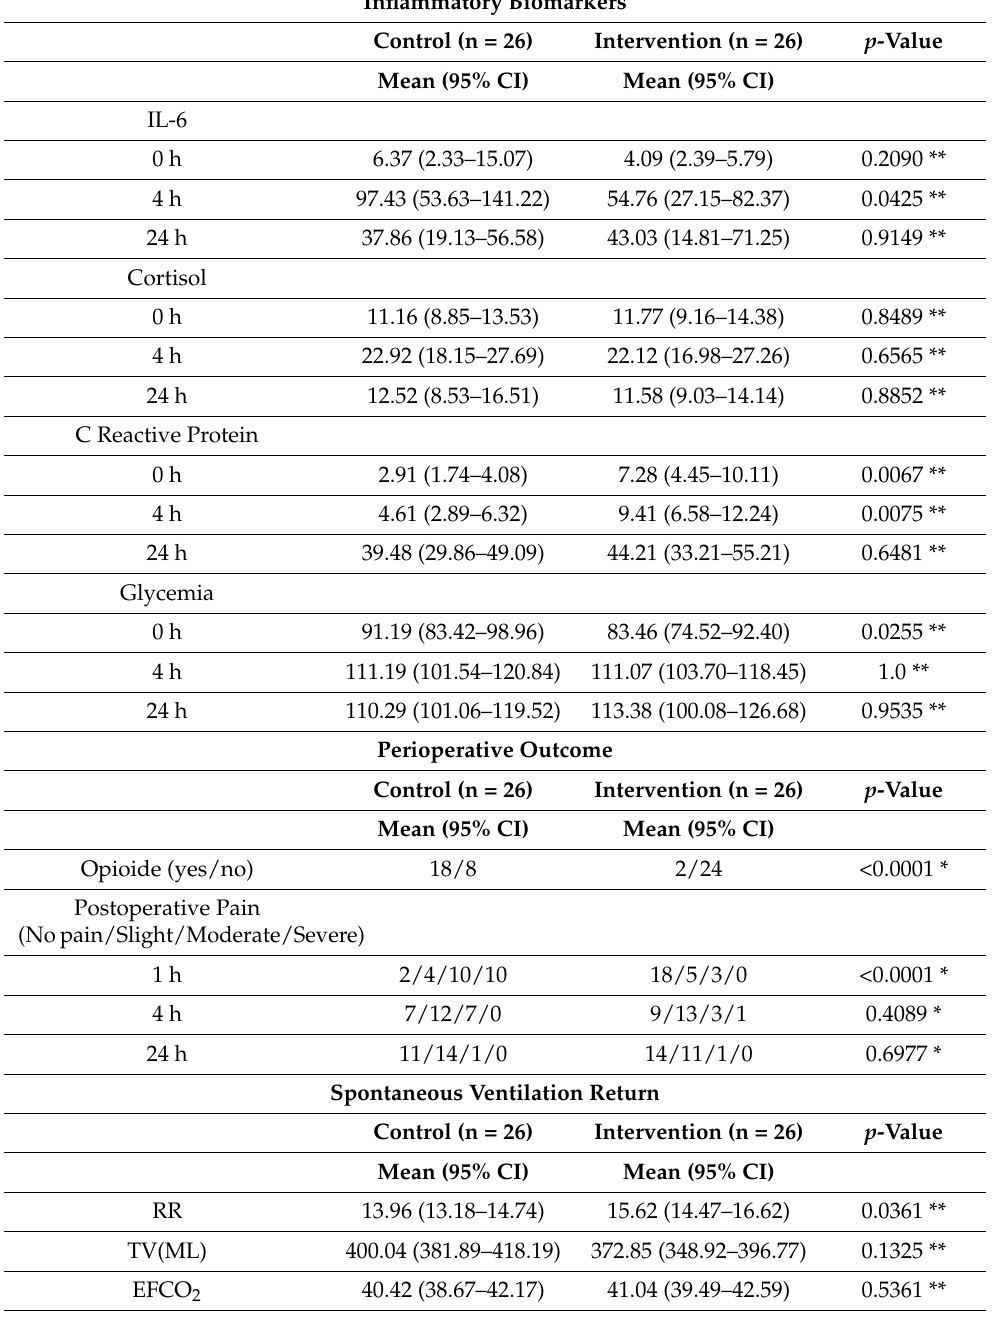
Table 2. Results from hypothesis tests for the non-demographic variables of the